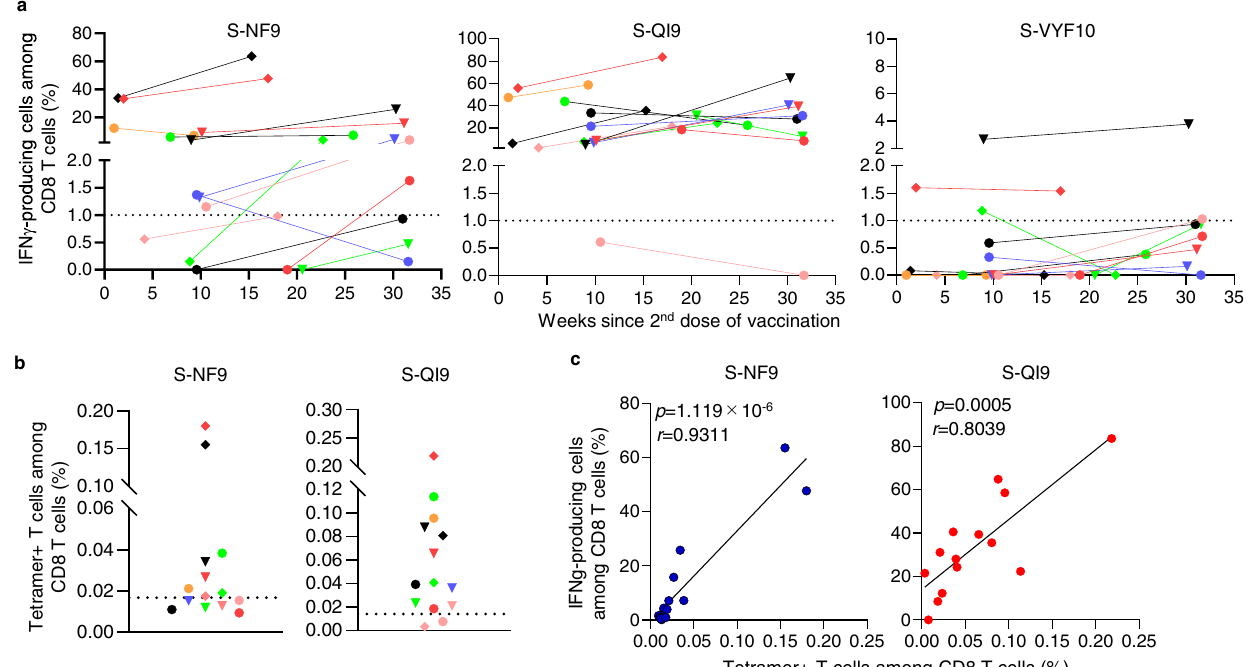
Fig. 6 | Induction and maintenance of long-term memory CD8 + T cells speci fi c forimmunodominantepitopes.a LongitudinalanalysisofHLA-A*24:02-restricted Tcellresponsesto2immunodominantand1subdominantspikeepitopesofSARS- CoV-2 after the second vaccine dose. The responses of SARS-CoV-2-speci fi c bulk Tcellsestablishedfrom14HLA-A*24:02 + ,vaccinatedindividualswereanalyzedat2 timepointsusingICSassaysafterexposuretoC1R-A2402cellsthatwerepre-pulsed with 1 μ M of NF9, QI9, and VYF10 peptides. The dotted line at 1.0% for IFN- γ - producing cells among CD8 + T cell population represents the threshold for a